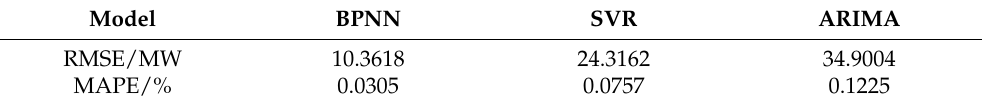
Table 1. Short-termforecastingperformanceofBPNN,SVR,andARIMAonlow-complexitysubsequences. Model BPNN